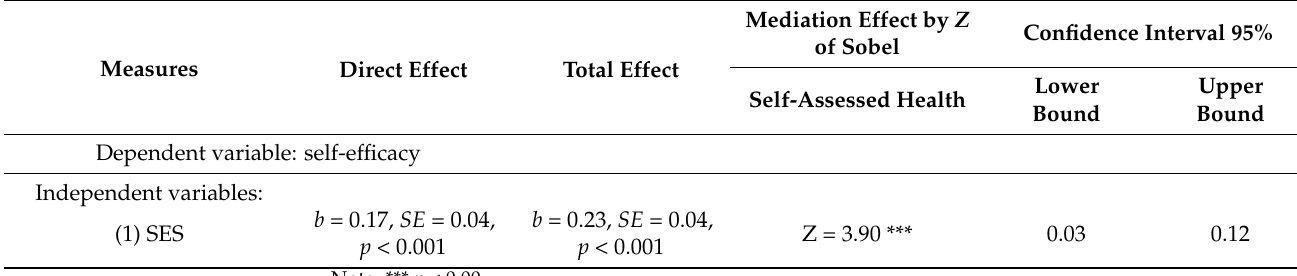
Table 5. The mediation effect of self-assessed health on